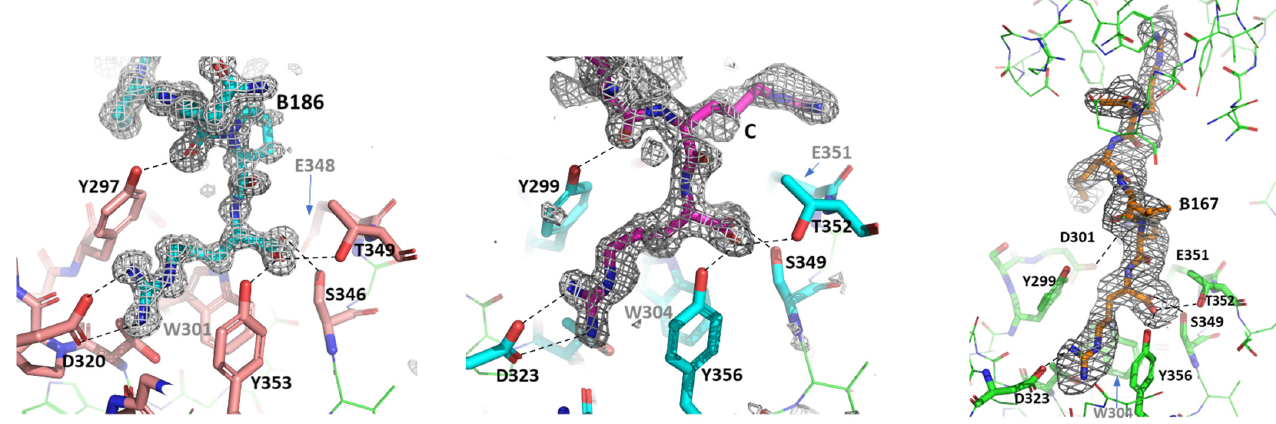
Figure 1. Illustration of the quality of the electron density maps within the ligand-binding sites of NRP1-b1/B186 ( left ), NRP2-b1/C ( centre panel ) and NRP2-b1/B167 complexes ( right panel ). Fo-Fc omit maps were calculated for the peptide ligands and displayed at 3.0, 1.5 and 1.5 σ levels for B186, C and B167 peptides, respectively. In each of the panels, the main residues forming the ligand-binding site are labelled and the hydrogen bonds between the ligand and the protein side chains are indicated by dashed lines. For clarity, water molecules are excluded from these images. Note that in the crystal structure of the NRP1-b1/B167 complex, the C-terminal arginine of the peptide forms hydrogen bonds only with one of the D323 atoms. In the structure of the NRP2-b1/B167 complex, one of the peptides bridges two molecules of NRP2-b1 protein and the electron density for the entire peptide is shown.